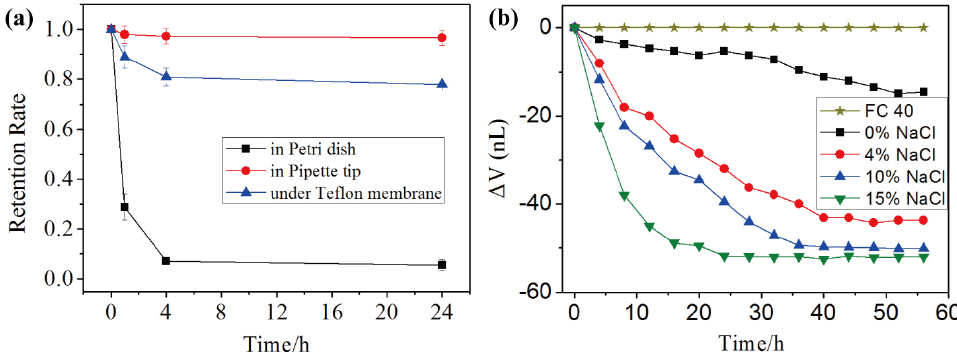
Figure 3. ( a ) Plot of the retention rate of double emulsions produced by the plastic-glass hybrid microfluidic device under different storage conditions as a function of time; ( b ) Plot of the change in the volume of the core droplets inside double emulsions ( ∆ V ) against different concentrations of NaCl and FC 40 oil in the continuous phase as a function of time.